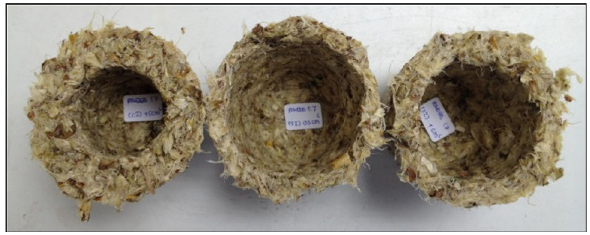
Fig. 2 Thickness of decomposable pots, from left: 1.5, 0.5 and 1.0